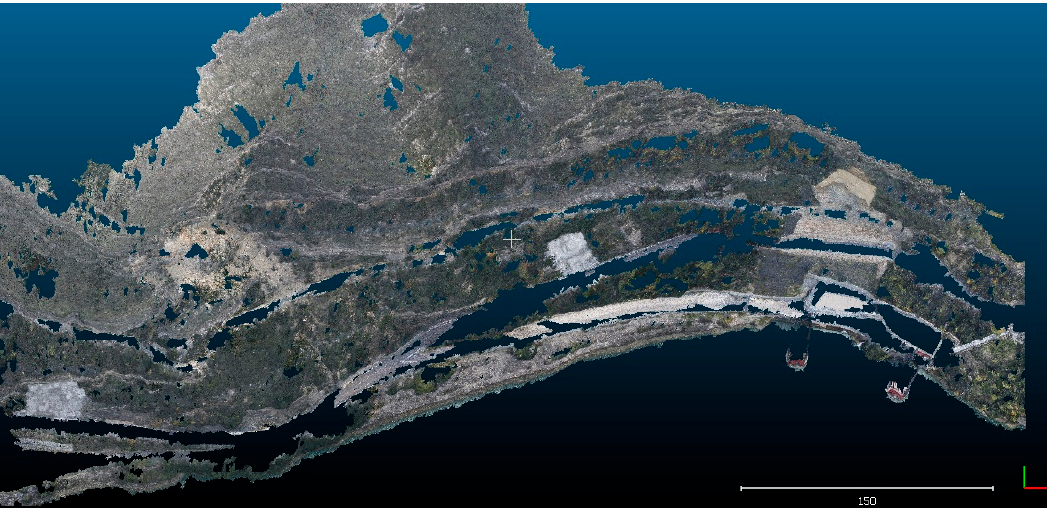
Figure 10. Top view of the CRP (Close-Range Photogrammetry) point cloud. In this image are visible the holes due to occlusions and vegetation.